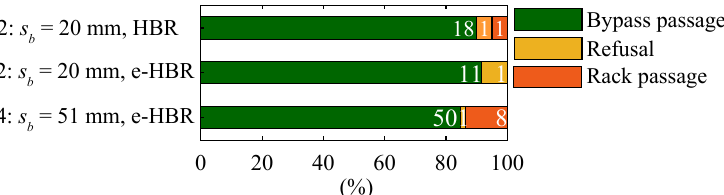
Figure 9. Results of the live fish tests with eels ( Anguilla anguilla ) without and with an electric field for different s b . The green bar represents the fish guidance efficiency FGE, and the sum of the green and yellow bars represents the fish protection efficiency FPE.